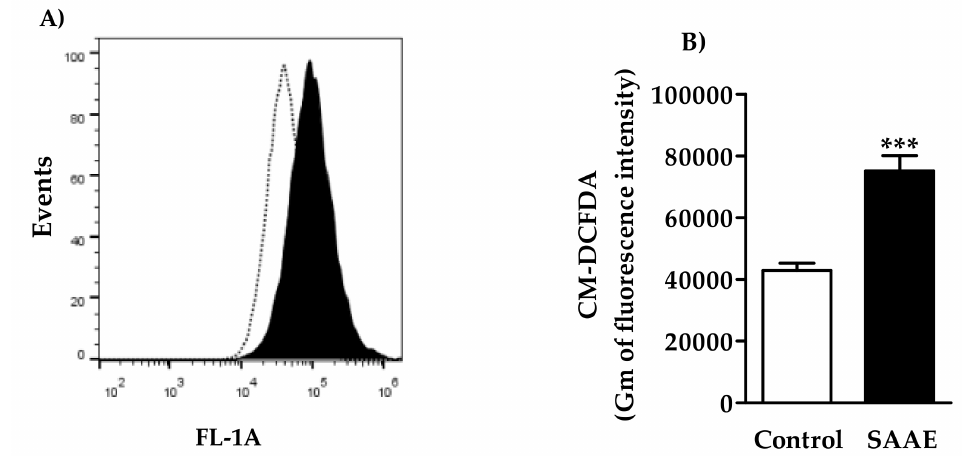
Figure 9. ( A ) Histogram and ( B ) graphical representation of the fluorescence intensity of ROS levels of B16F10Nex-2 cells treated with the SAAE (65 µ g/mL). Data are expressed as the mean ± SEM ( n = 3) in duplicates. *** p < 0.0001 compared with the untreated control